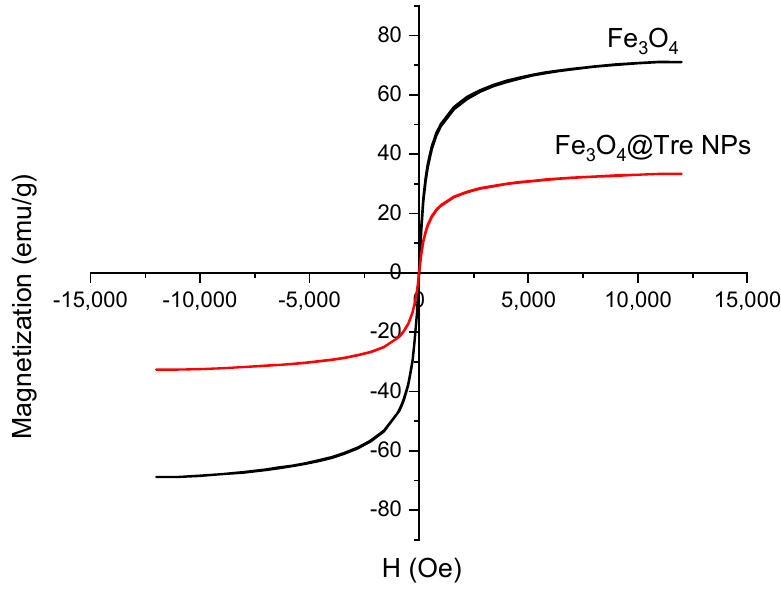
Figure 2. VSM diagrams of Fe 3 O 4 and Fe 3 O 4 @Tre NPs.